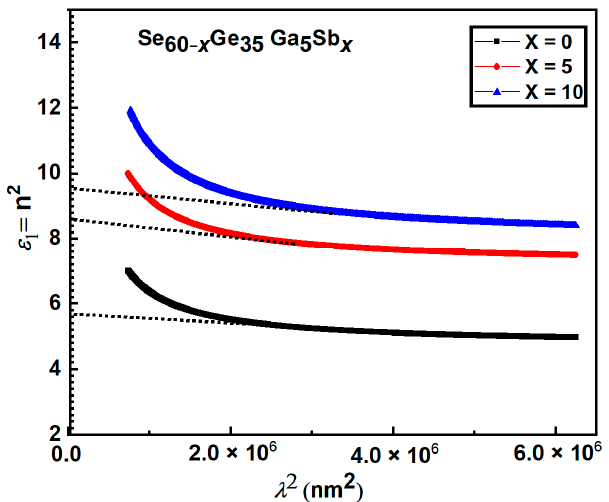
Figure 10. Plots of ε 1 against λ 2 for Se 60 − x Ge 35 Ga 5 Sb x thin films. Table 5. Calculated values of the optical parameters ε L , ε ∞ , ω p , and λ o for the prepared films.